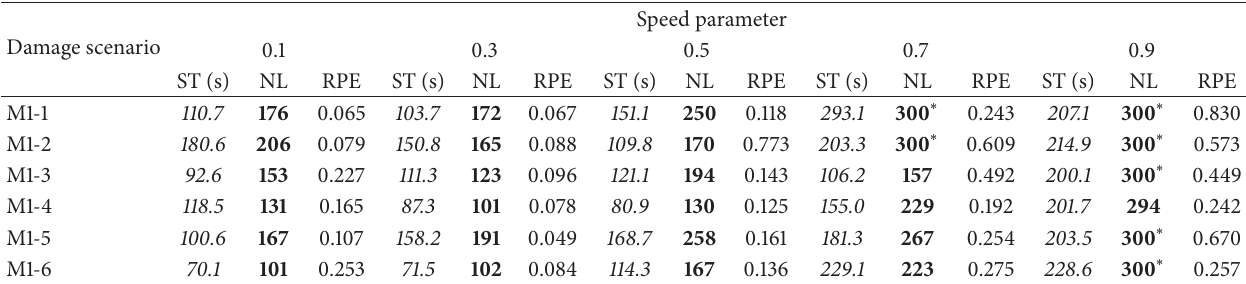
Table 6: Solution time, loops, and RPE of DDMFD method for model 1.